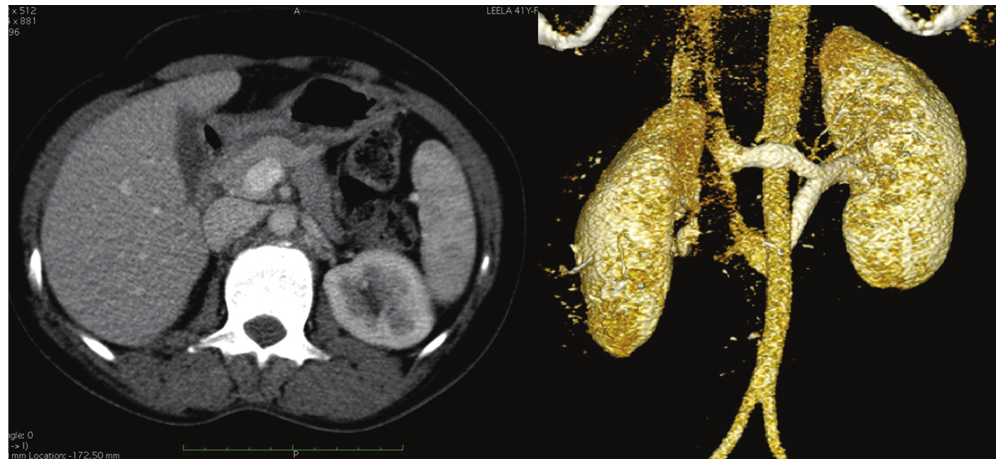
figure 4- circumaortic left renal